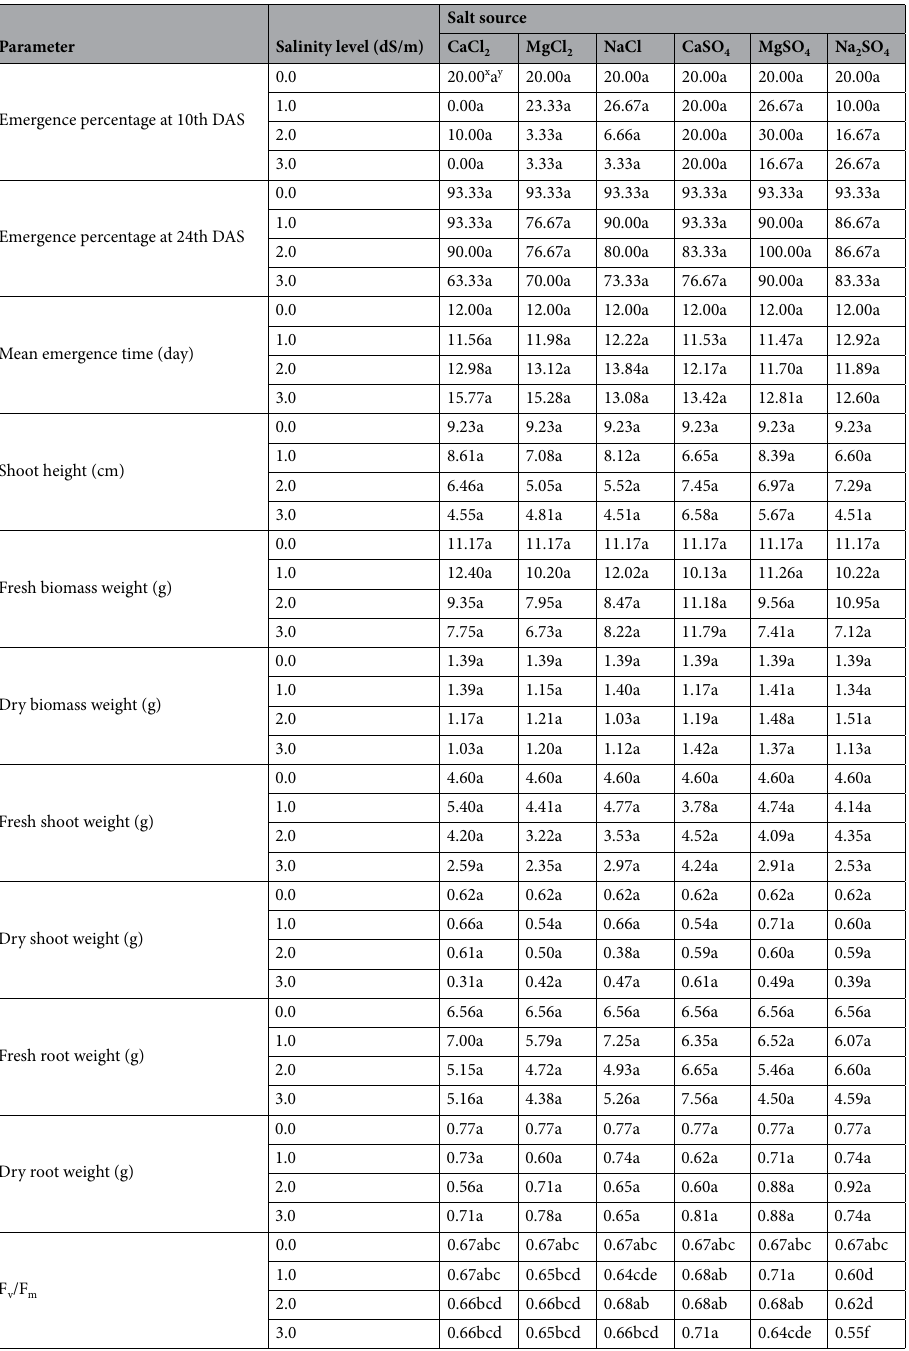
Table 2. The interaction effects of S × L on I-29 faba bean genotype. x Each value is the mean of three replications. y Within salt source and salinity level of each parameter, means followed by the same letter are not significantly different at the 5% level according to Duncan’s multiple range